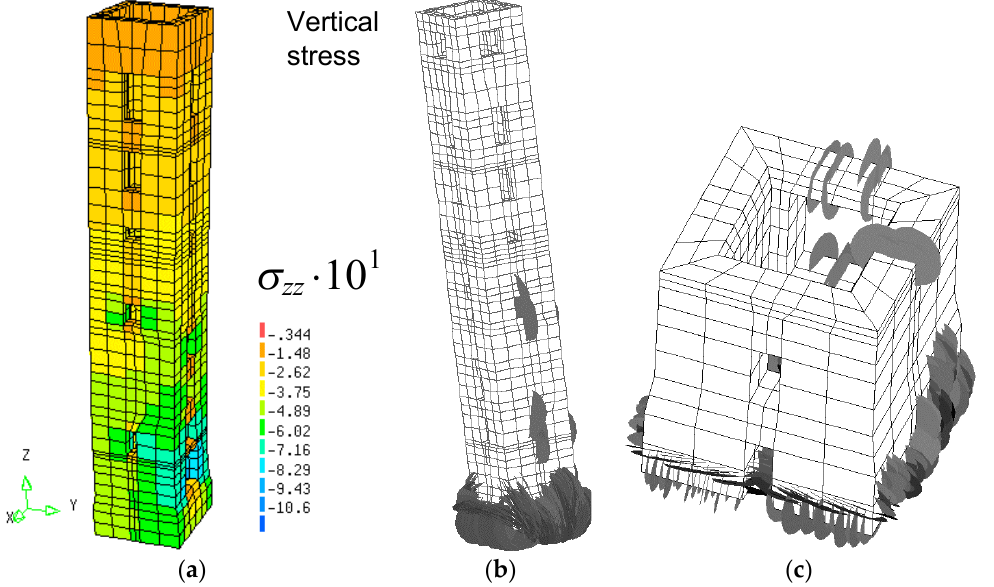
Figure 2. Torre Sineo: ( a ) vertical stresses (MPa); ( b ) overall crack pattern; ( c ) detail crack pattern of the basement area, corresponding to a 3% deviation from verticality.